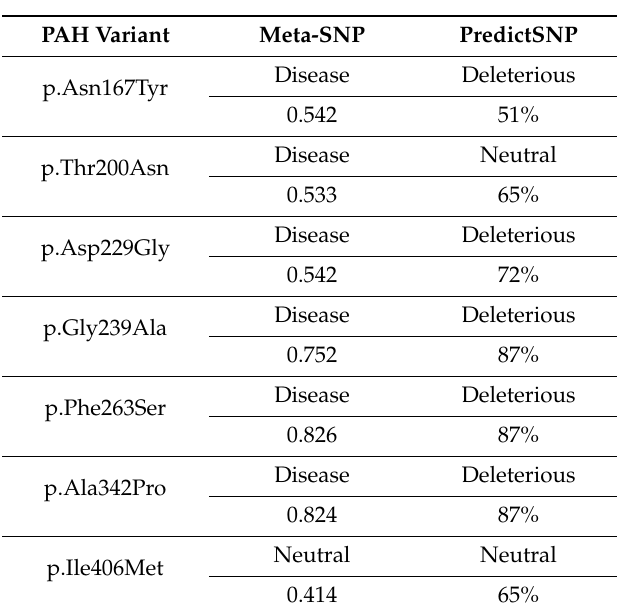
Table 2. The results of in silico PAH variant pathogenicity prediction by Meta-SNP and PredictSNP. “Neutral” referred to a neutral variant, “Disease” and “Deleterious” to disease-causing variant. Variant was predicted to be disease-causing when outputs of Meta-SNP were > 0.5. The percentages express the expected prediction accuracies of